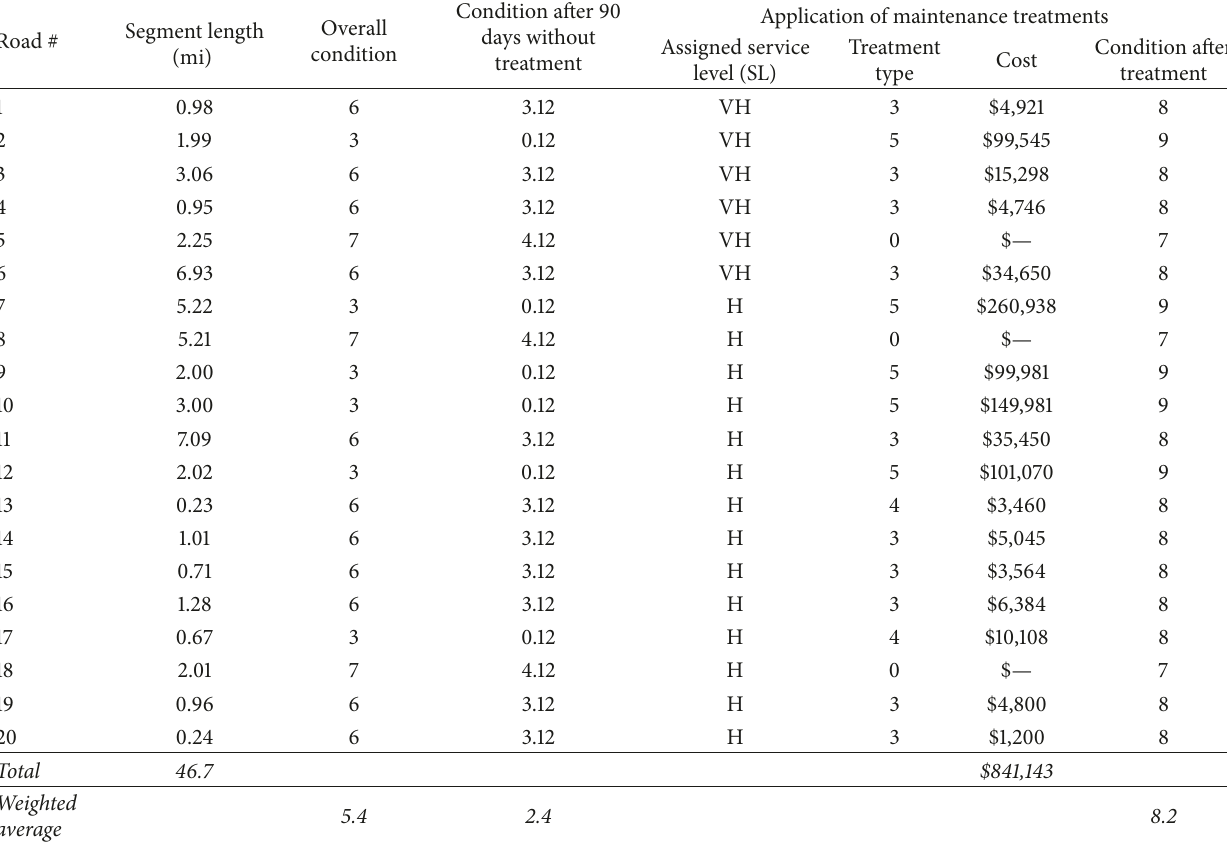
Table 5: Summary of road conditions.